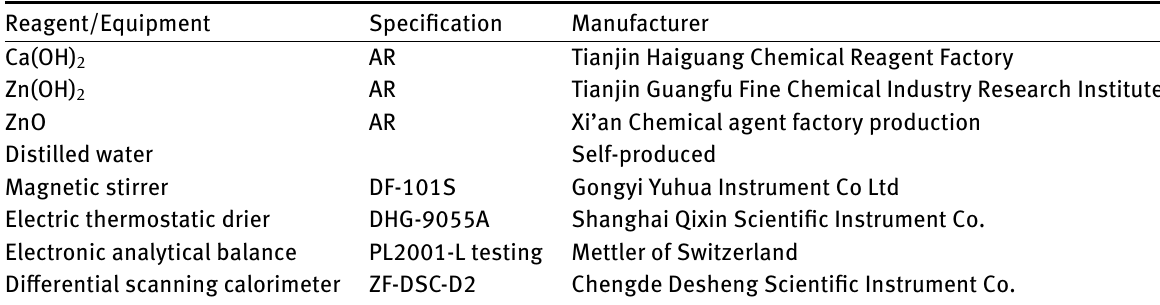
Table 2: Chemical reagents and equipment used in this experiment